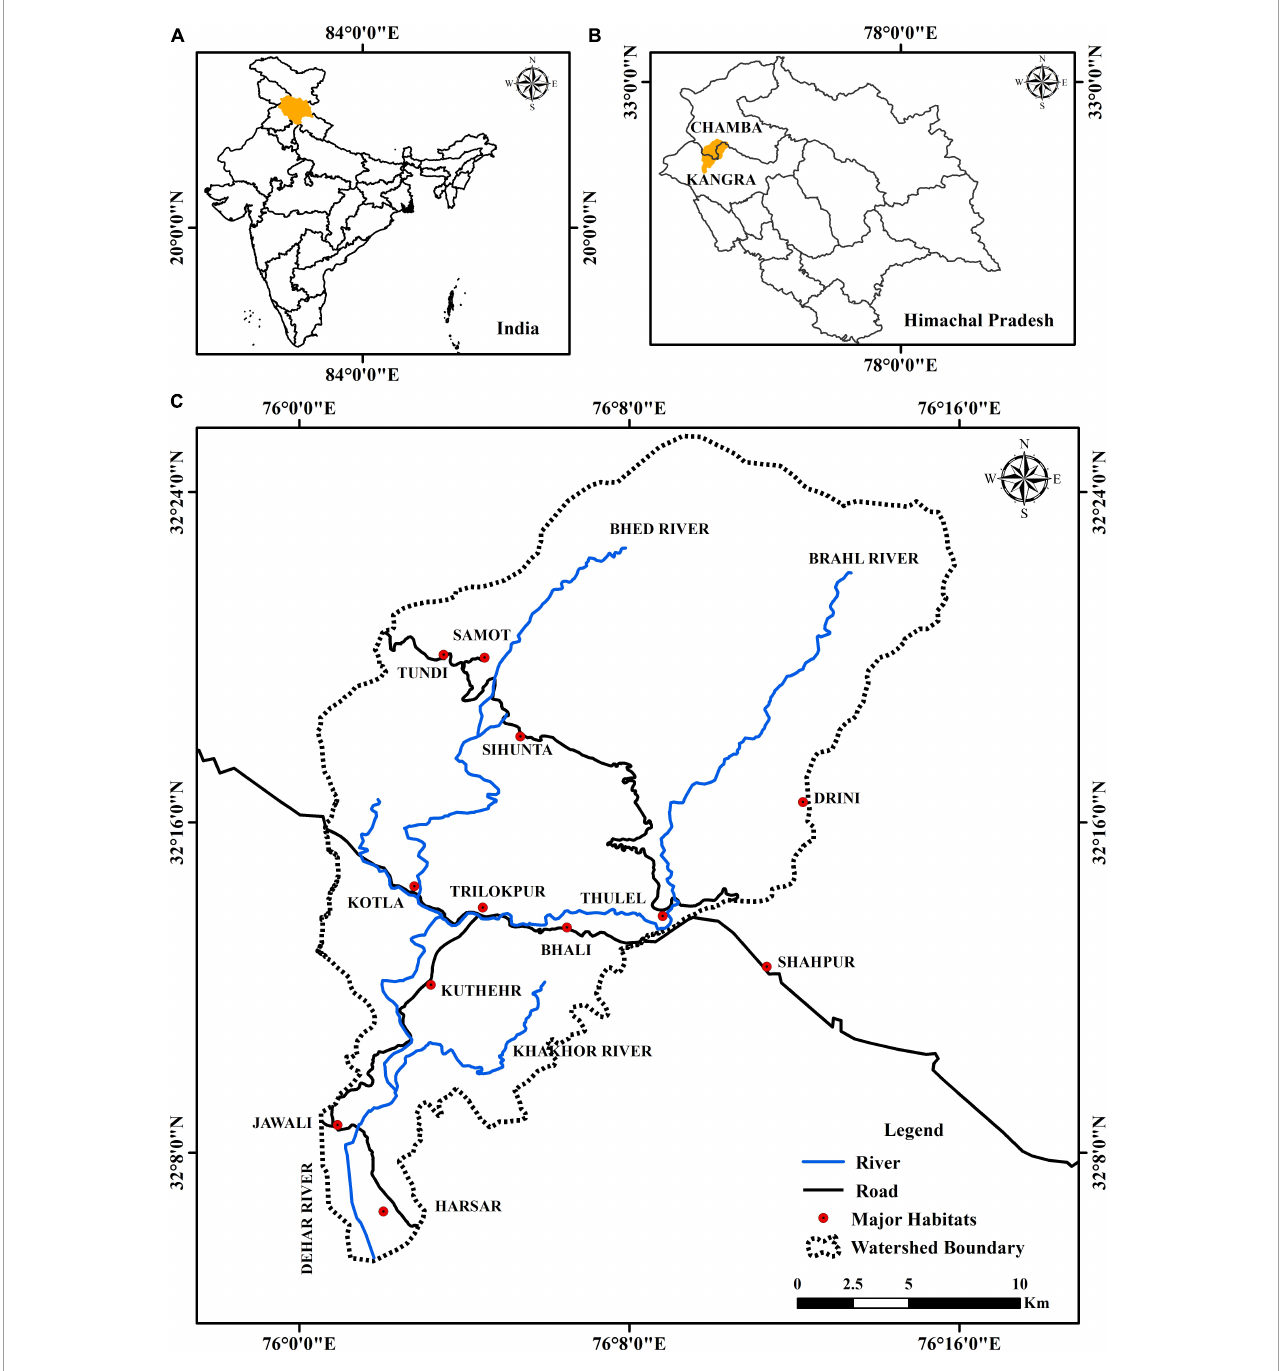
FIGURE1 Location maps. (A) Map of India showing the location of the Himachal Pradesh state (shaded by yellow color). (B) Map of the Himachal Pradesh state showing area (shaded by yellow color) covered by the Dehar watershed. (C) Enlarged map showing the Dehar watershed.